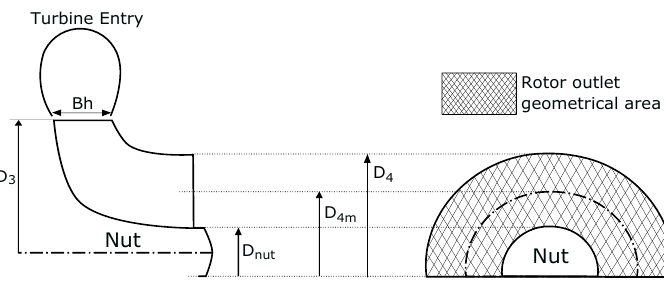
Figure 8. Geometrical description of vaneless turbine.